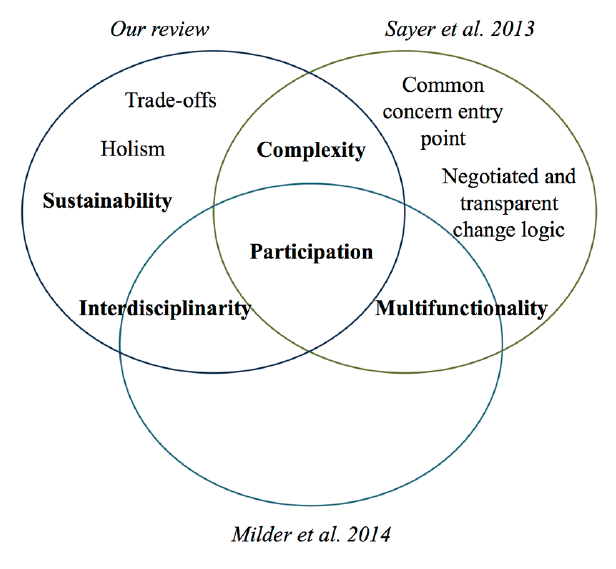
Fig. 2 . Summary of main concepts identified in Table 3. The five concepts in bold are the focus of discussion in this